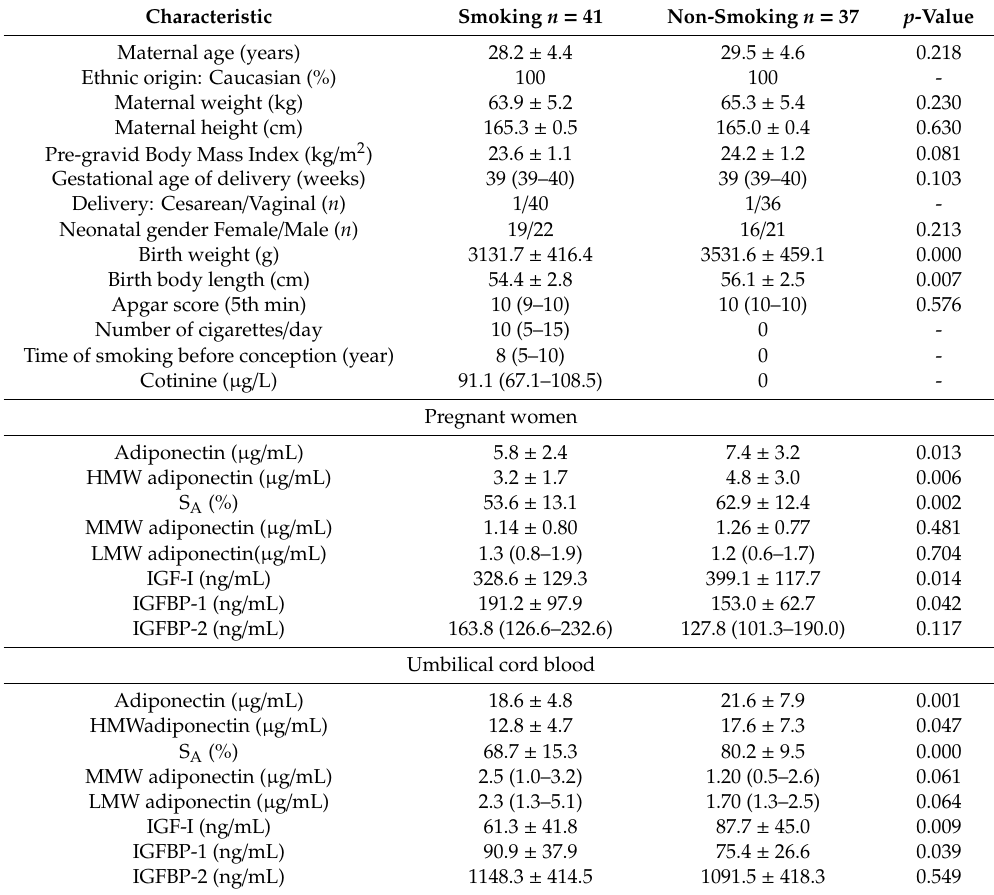
Table 1. Clinical characteristics and biochemical measurements in smoking and non-smoking matched maternal cord pairs ( n =